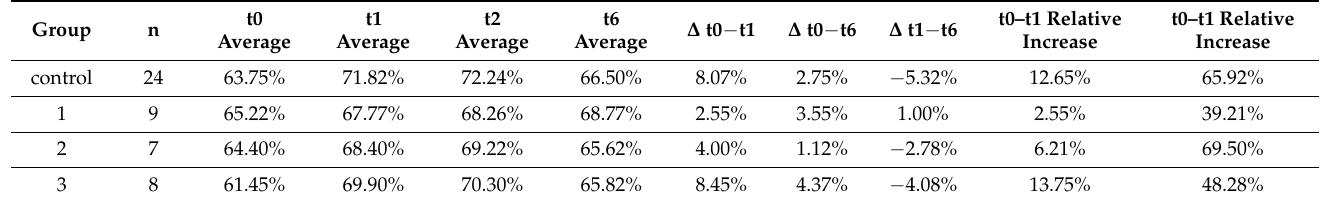
Figure 5. Near-infrared spectroscopy images from the control group, taken at t0 ( left ), t1 ( middle ), and t6 ( right ). Table 2. Overview of the oxygen saturation percentage mean values measured by the near-infrared spectroscopy at t0, t1, t2, and t6. Relative changes in the oxygen saturation between the main time points, negative values representing a decrease in values.